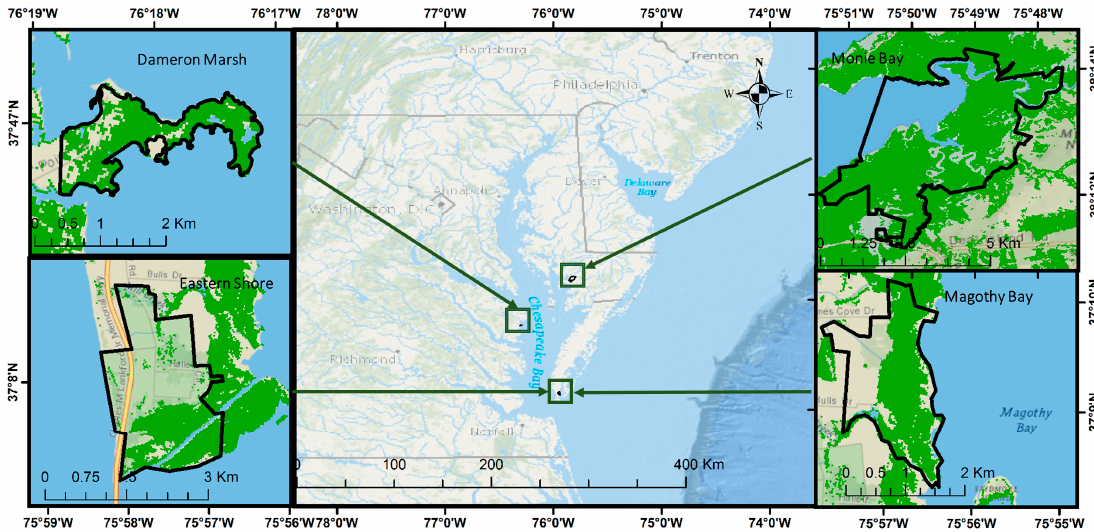
Figure 1. Location of the four study areas within the Chesapeake Bay (tidal wetlands and marshes areas are highlighted in green).